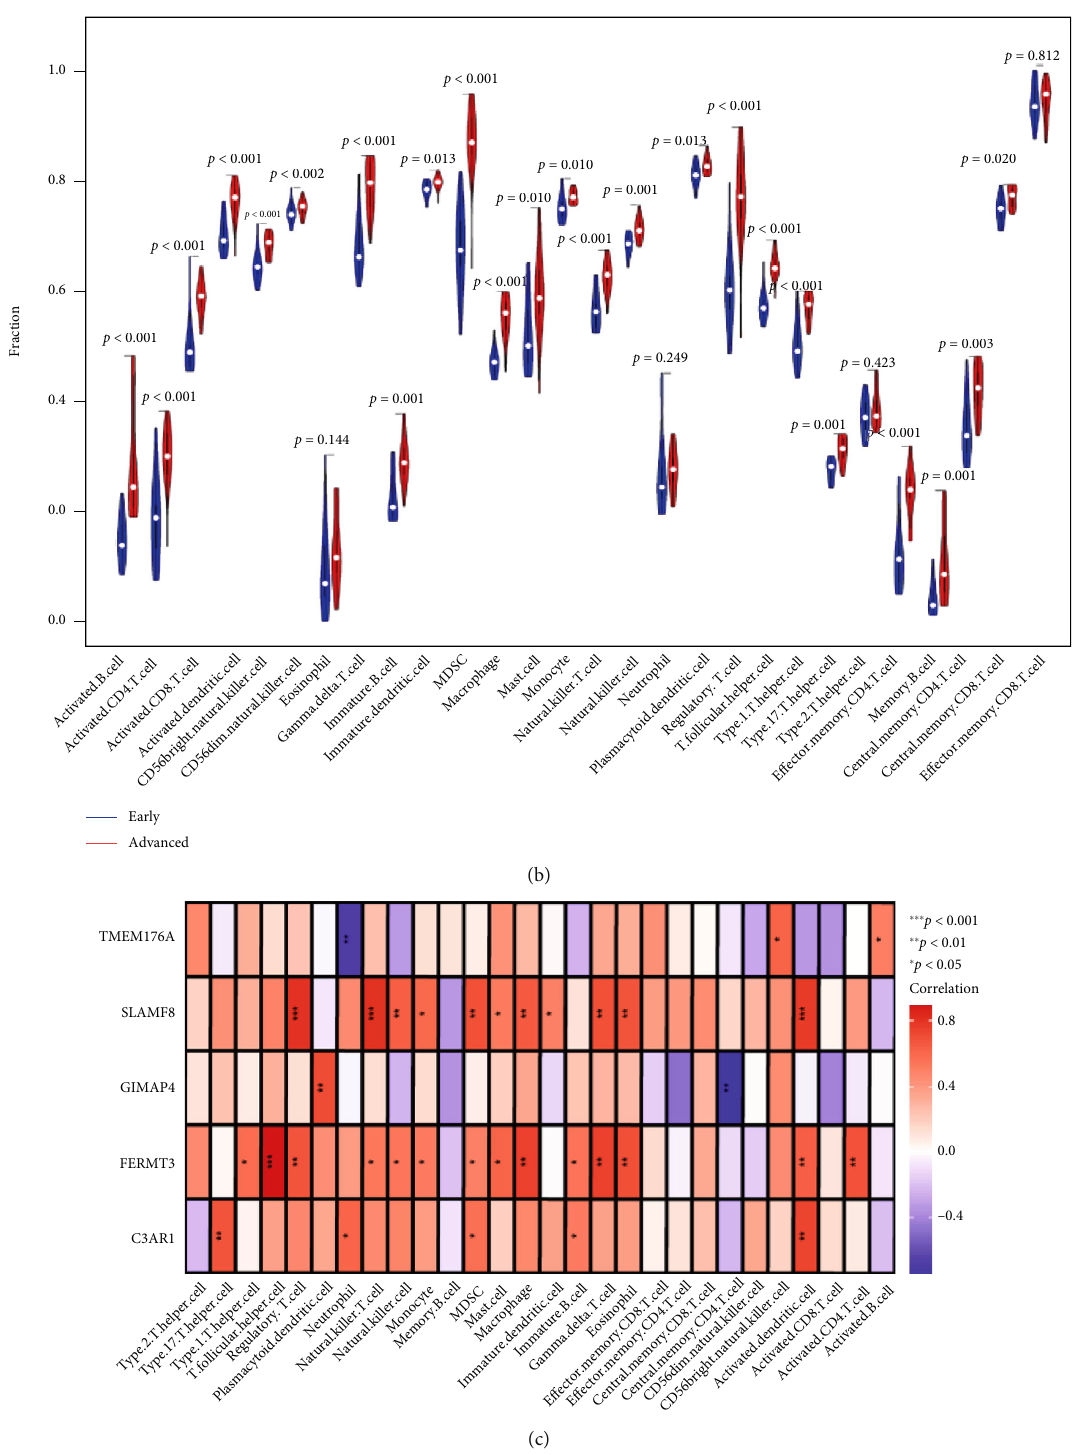
Figure 8: Analyzing the immune in fi ltration related to the advanced-stage carotid atherosclerotic plaques and the correlation analysis between 5 hub genes and immune cells. (a) Heat map and (b) violin plot highlighting the distribution of the 28 types of immune cells observed during the early- and advanced-stage carotid atherosclerotic plaques. (c) Relationship between the 5 hub genes and the in fi ltration levels of the immune